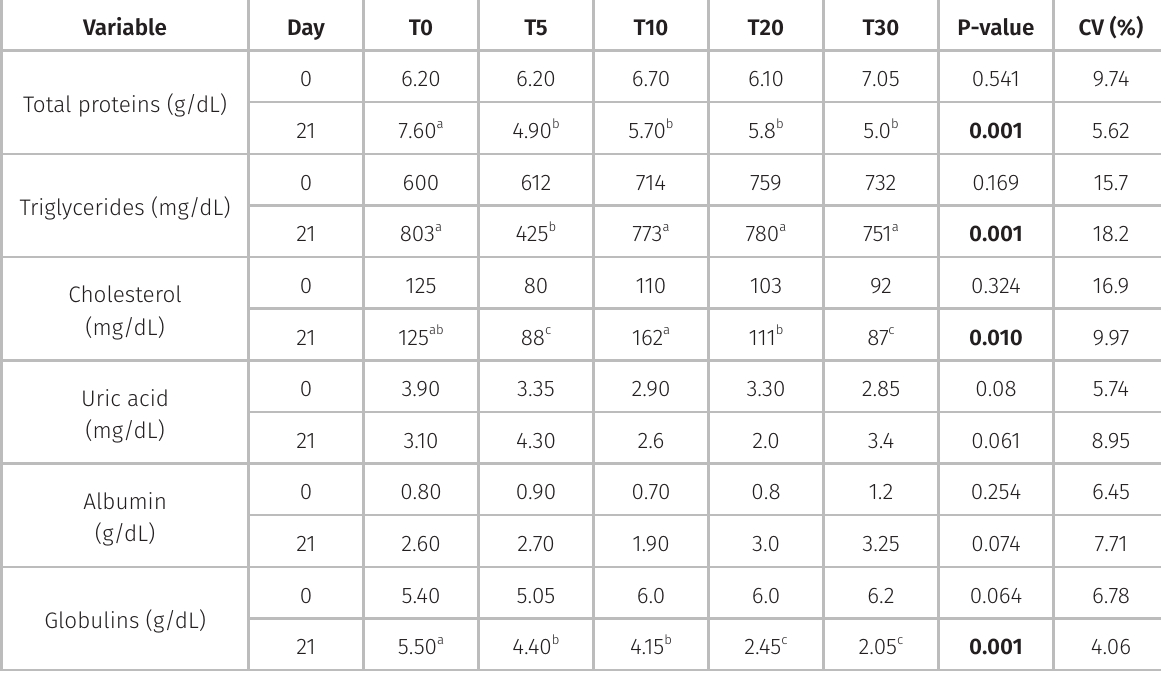
Table III. Serum biochemistry of laying hens fed with propolis levels on days 0 and 21 of the experiment.